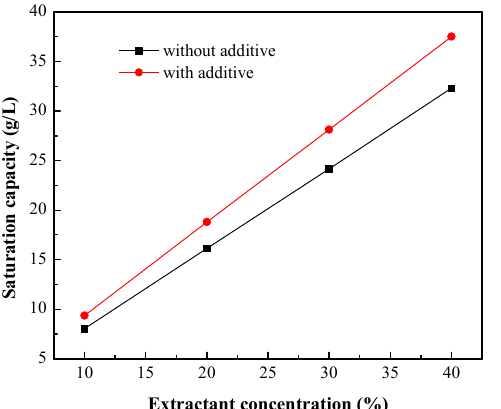
Figure 3. The saturation capacity of an extractant with and without the compound additive of organic acid and strong alkali (Conditions: zinc concentration 8 g/L, initial pH 3.0, A/O ratio 50:50, stirring speed 1000 rpm, and extraction time 15